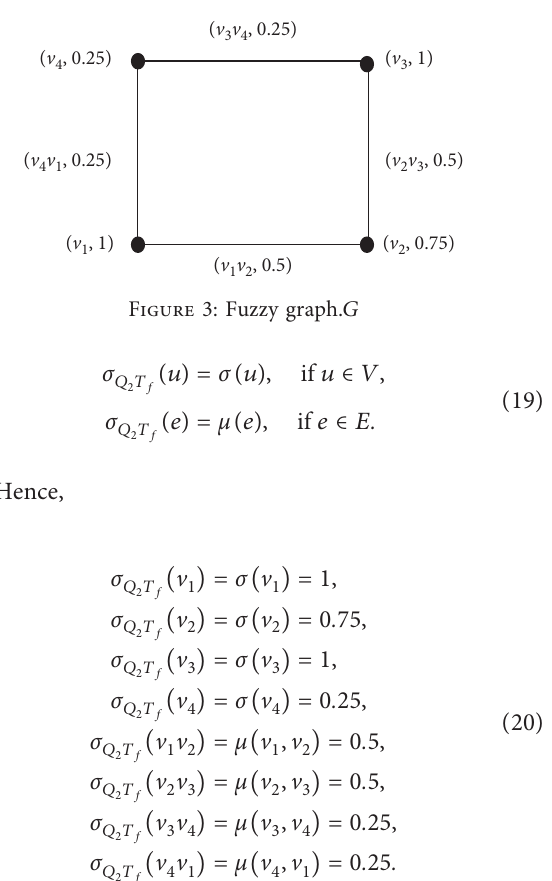
Figure 2: 2-Quasitotal fuzzy graph of G .